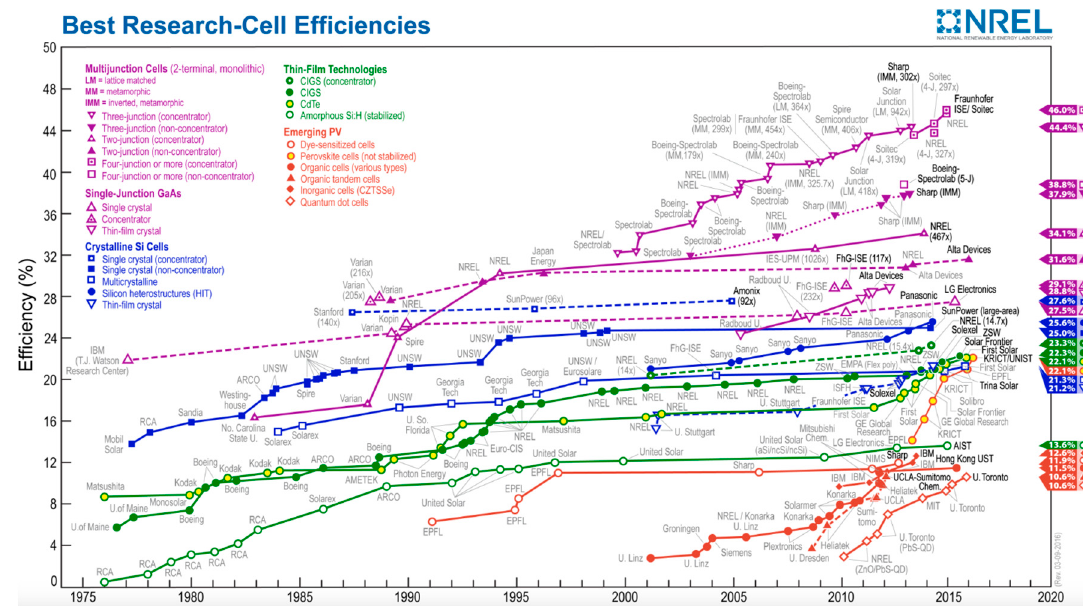
Figure 9. NREL Chart showing best research ‐ cell efficiencies [136].